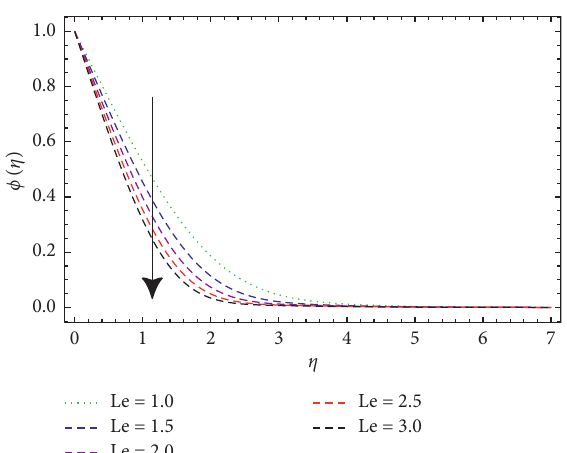
Figure 16: Influence of the ϕ ( η ) profile via Le.